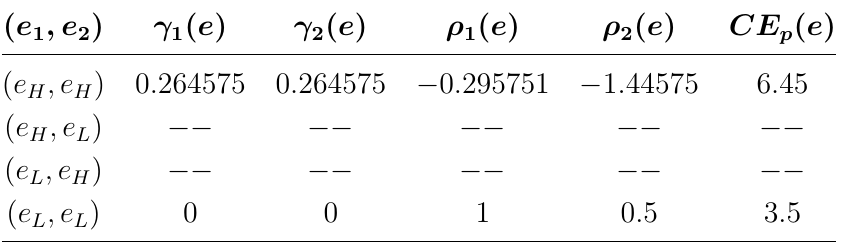
Table 3. Optimal strongly collusion-proof contracts of Example